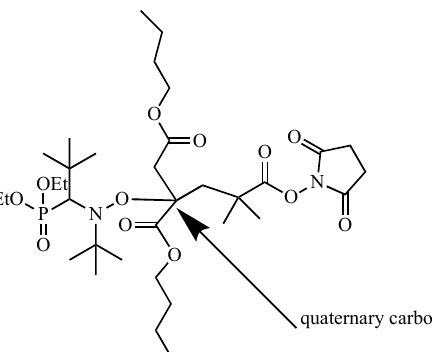
Figure 1. Possible adduct formed during the homopolymerization of dibutyl itaconate (DBI) via NMP with NHS-BlocBuilder.